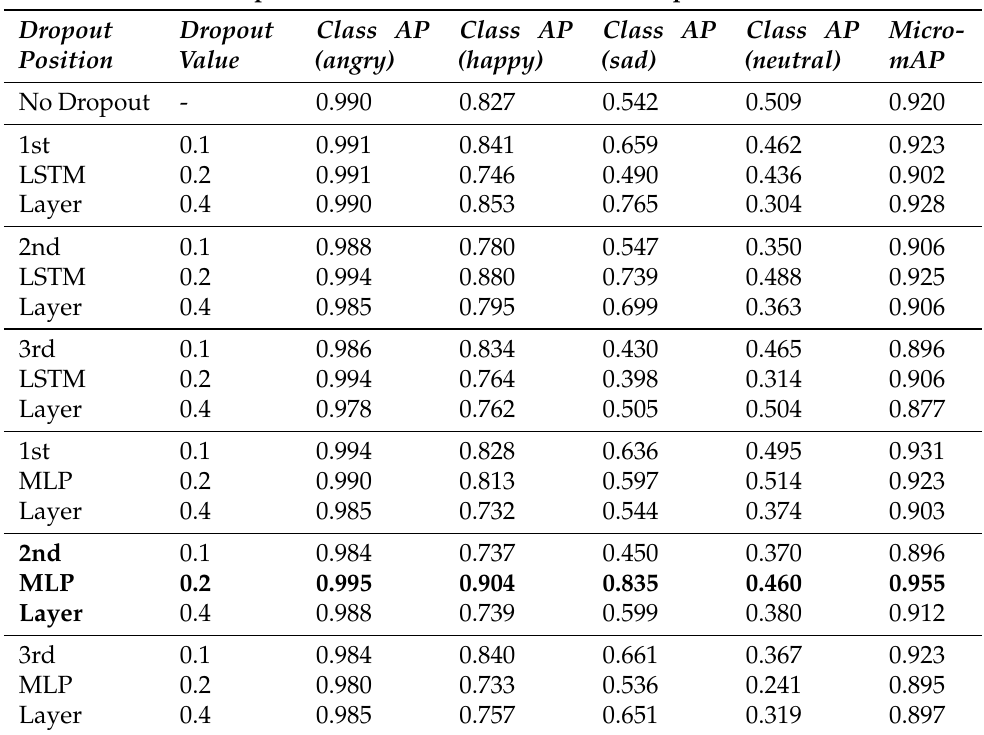
Table 4. Performance evaluation of proposed method with different values and positions of the dropout layer.